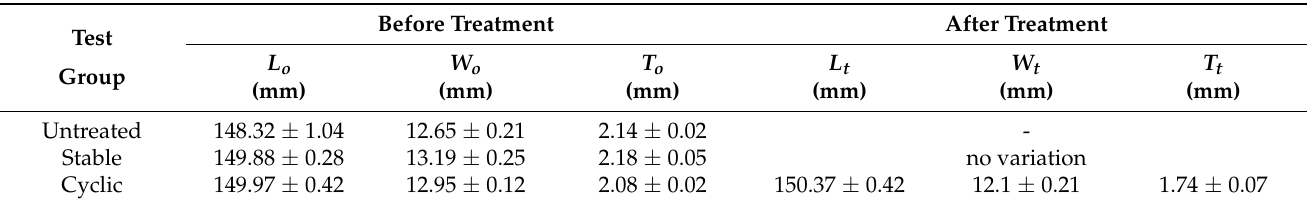
Table 3. Dimensions of 3D-printed specimens before and after heating